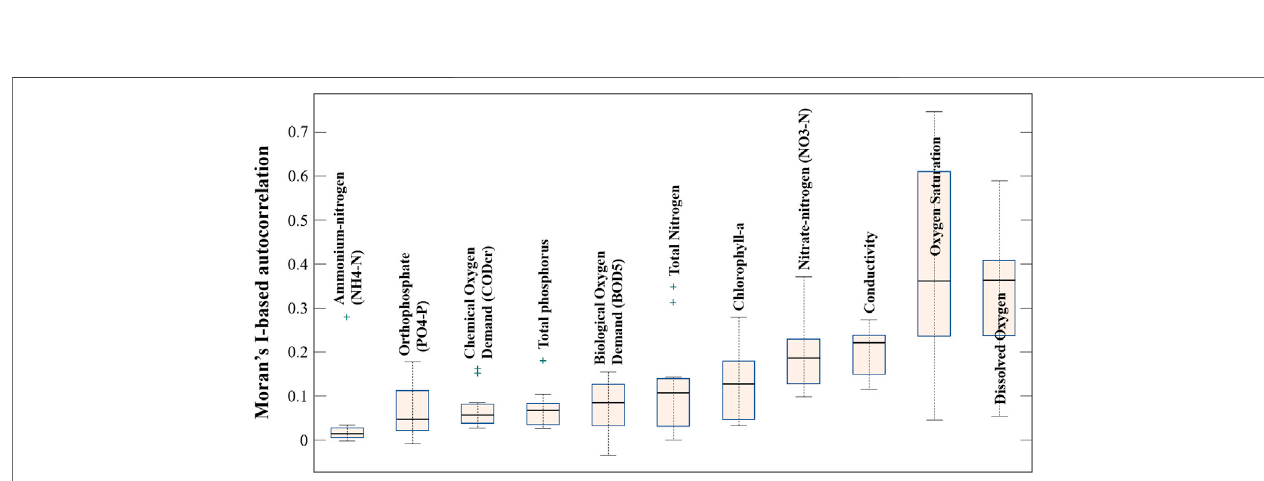
FIGURE 6 | Geary ’ s C neighbouring dependence of the water quality parameters of Hungarian water bodies. Smaller values indicate higher local spatial